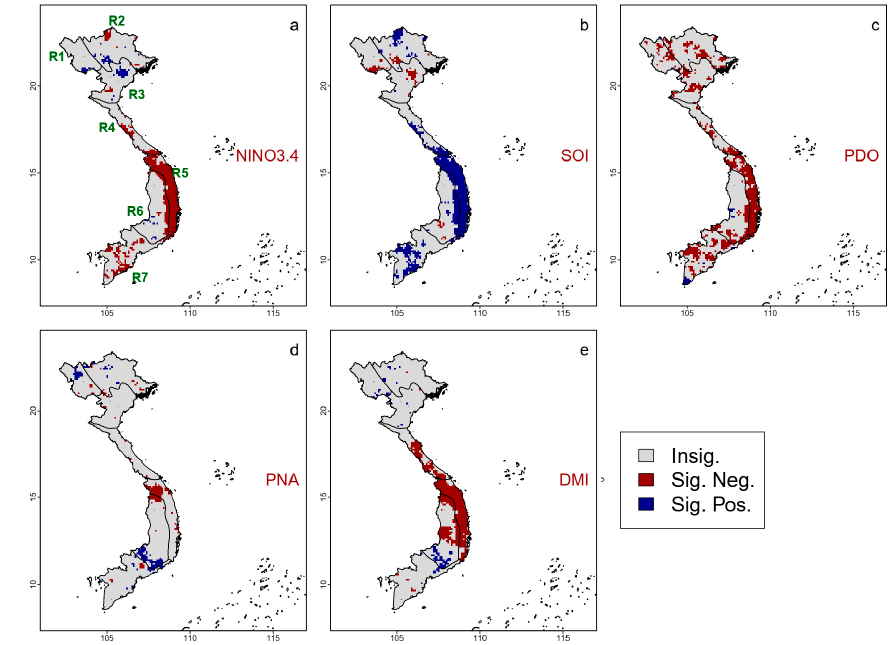
Figure 8. Maps showing the significant relationships between the frequency of heavy precipitation days and climate indices representing teleconnections: ( a ) nino34, ( b ) the Southern Oscillation Index (SOI), ( c ) the Pacific Decadal Oscillation (PDO) index, ( d ) the Pacific North American (PNA) Index, and ( e ) the Dipole Mode Index (DMI). Blue (red) pixels indicate a significant positive (negative) relationship at the 5 % level. Seven climate regions are also shown (polygons bounded by black lines). Table 3. The percentage of grid cells showing a significant relationship (at the 5 % level) between the frequency of precipitation extremes and the five climate indices across the national and regional scale. The field significance of the relationship is highlighted in bold. Region nino3.4 SOI PNA